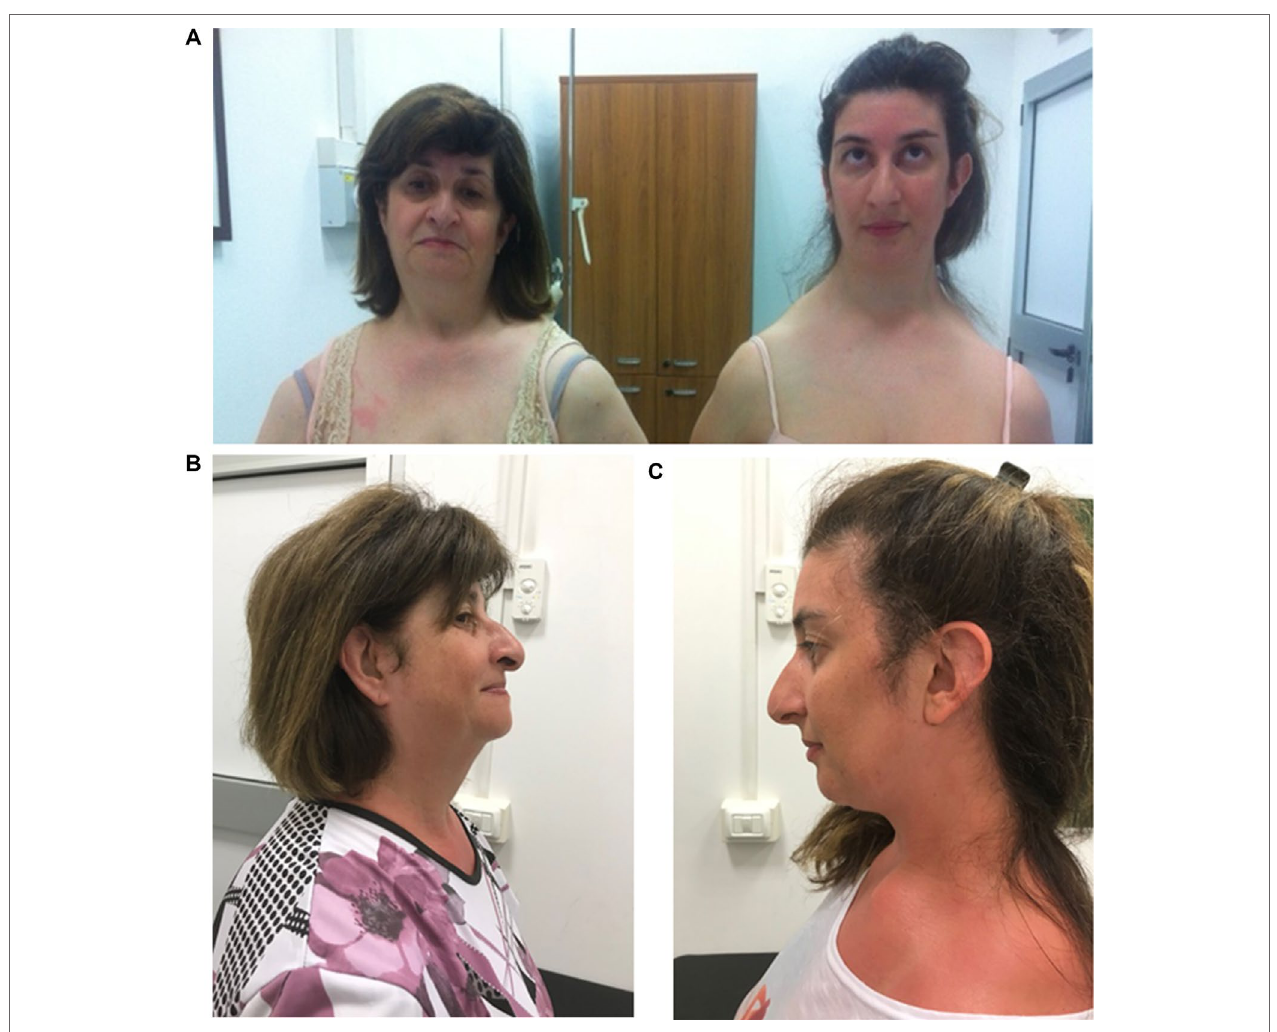
FIGURE 1 | Frontal (A) and lateral (B , C) view of the patient and her